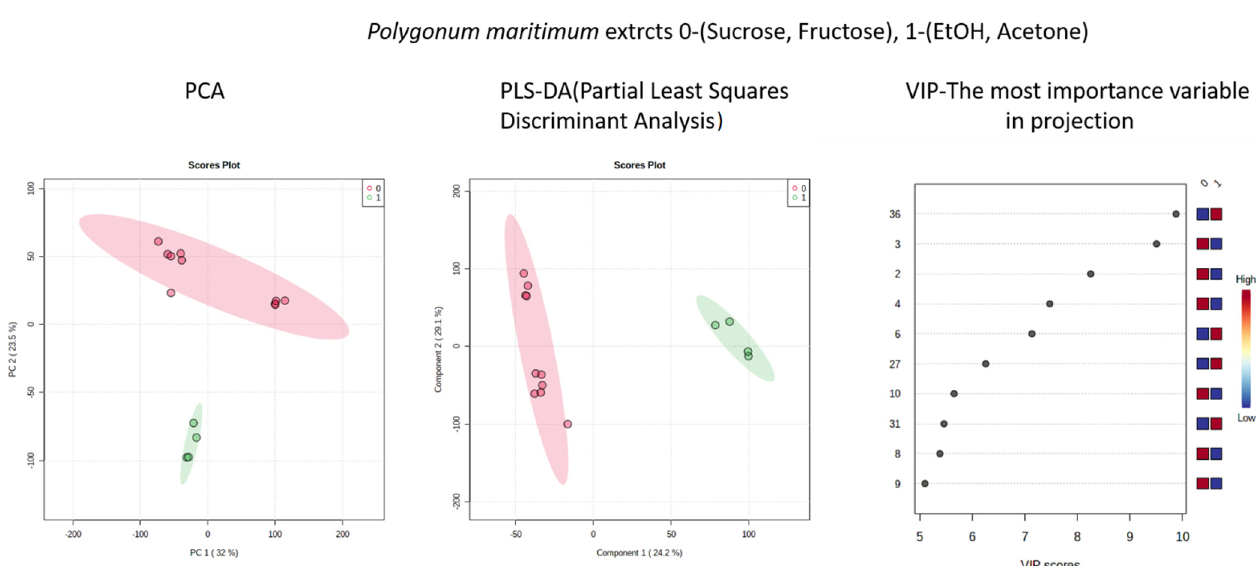
Figure 3. Examples of average HPLC chromatograms of Polygonum maritimum L. (sea knotgrass) extracts (UV 254 nm). The major peaks are numbered according to Table 2. The relative signal intensities shown on the X-axes are significantly stronger in both acetone and ethanol extracts than in NADES.